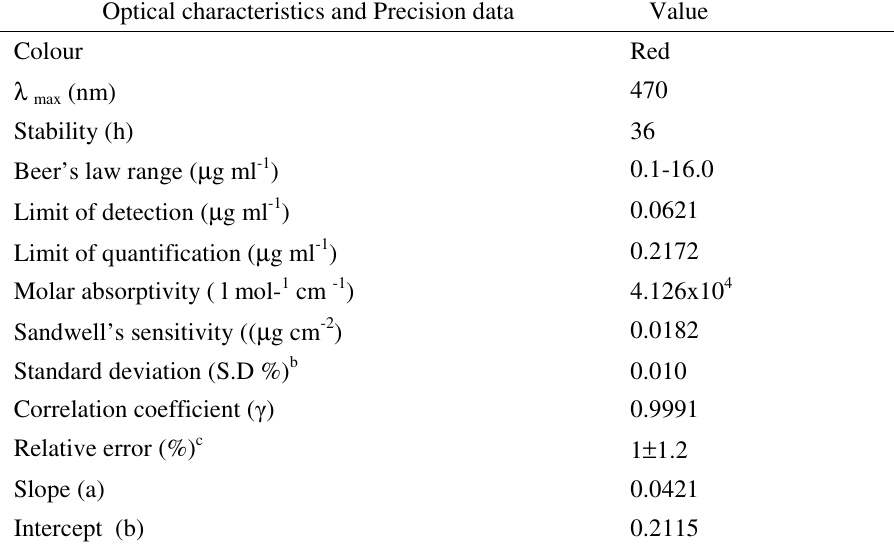
Table 4 . Optical charactistics and precision data of 4, 4-azo-bis-3, 3 ′ 5, 5 ′ -tetra bromo aniline Optical characteristics and Precision data